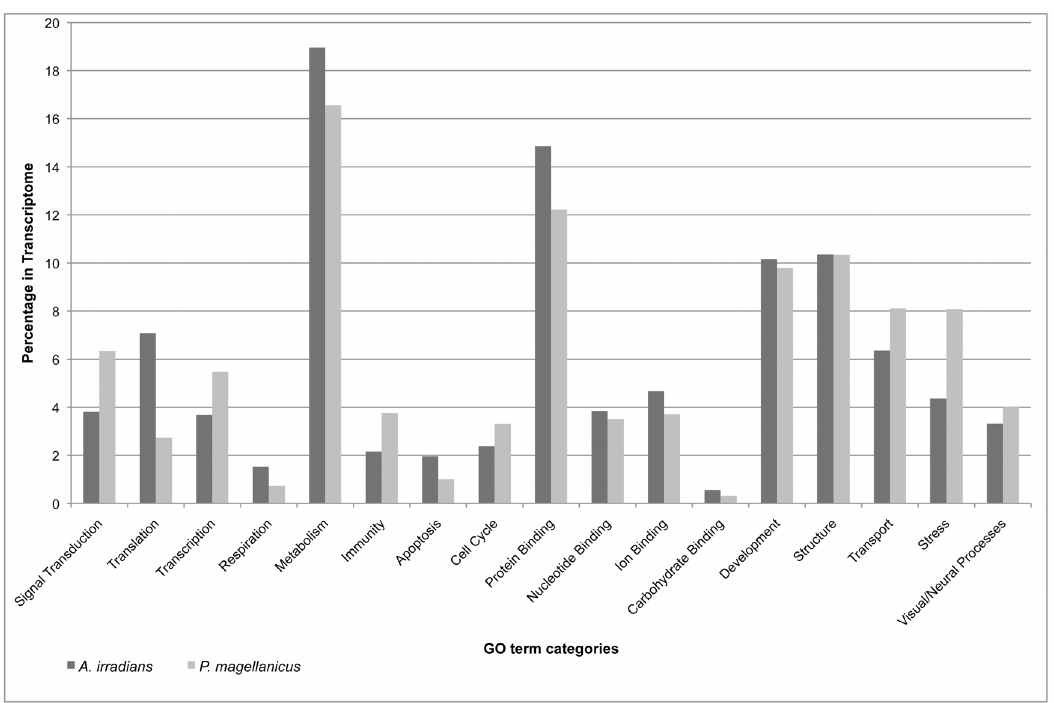
Figure 4. Distribution of Gene Ontology (GO) term categories in A.irradians and P.magellancius eye transcriptomes. Bars show the percent of sequences with a GO term annotation for each category.